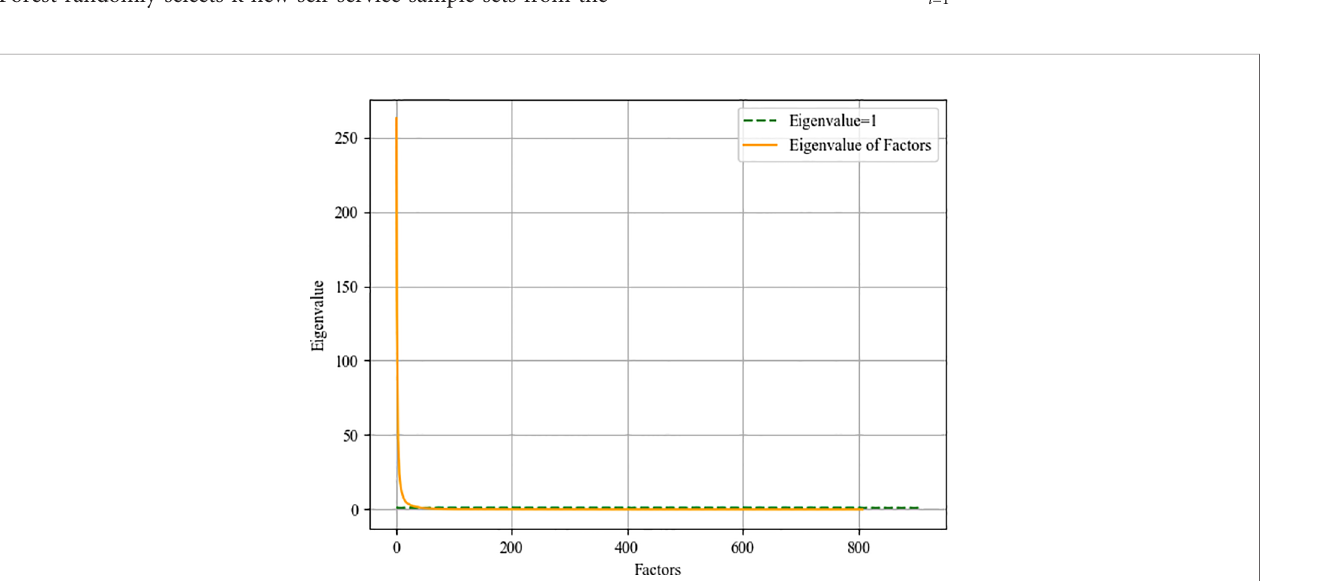
FIGURE 8 | Eigenvalue curve of